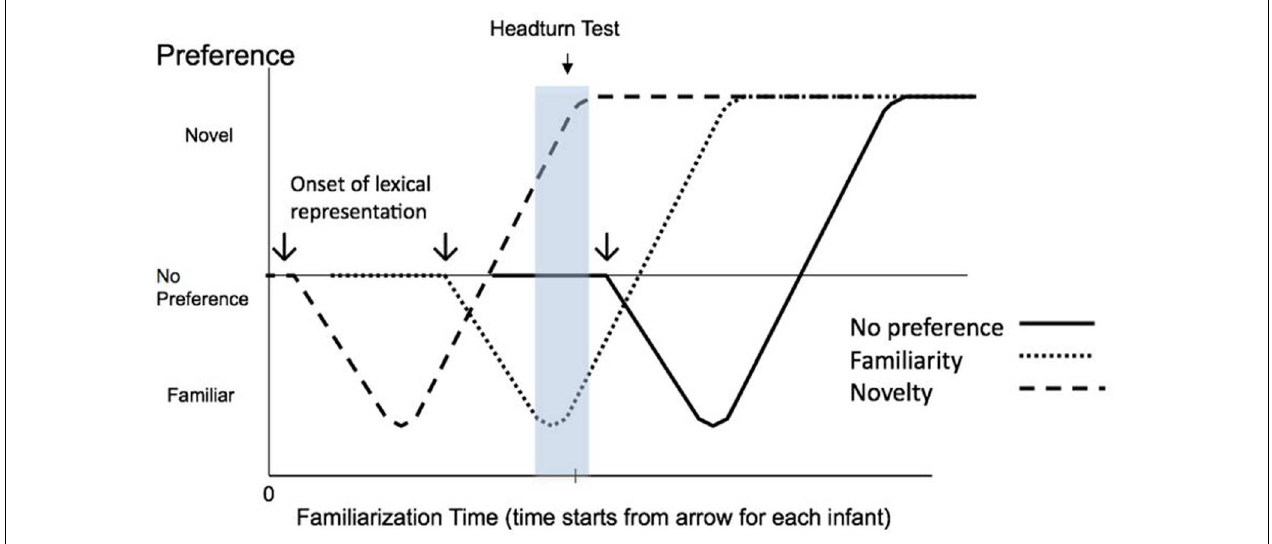
FIGURE 1 | Schematic predicted responses of three infants at different levels of lexical advance (all three figures are redrawn from Hunter and Ames, 1988). The downward arrows indicate the onset of lexical representation for each infant. The hypothesized curve for each infant represents his or her response to lists of (untrained) familiar words contrasted with unfamiliar words. The shaded area demonstrates that at specific testing points novelty and familiarity would both indicate the recognition of word forms (dashed lines), while no preference would indicate a lack of sensitivity to word forms (solid line). The vertical axis is the strength of the familiarity or novelty effect. The horizontal axis represents the time for a novelty effect to shift to a familiarity effect. Each infant would have their own individual time scale for beginning to recognize words in everyday life, although for clarity the three infants depicted in this figure are treated as having identical time scales for the shift in word-form